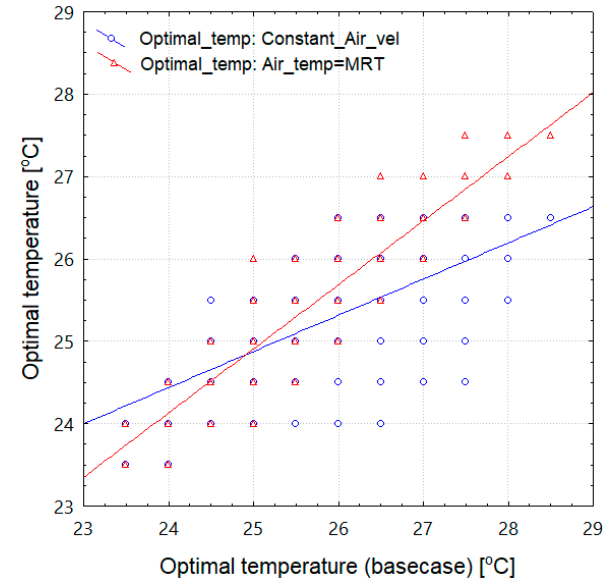
Figure 10. Optimal setpoint temperature error between the basecase and two scenarios.